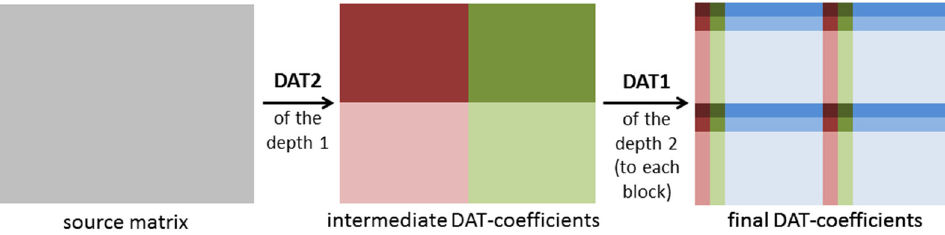
Figure 9. Mix of DAT1 and DAT2.